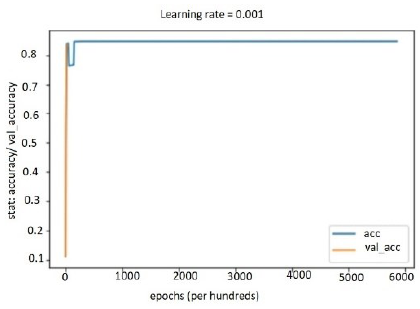
Figure 13. Training accuracy/validation accuracy versus epochs for text modality.